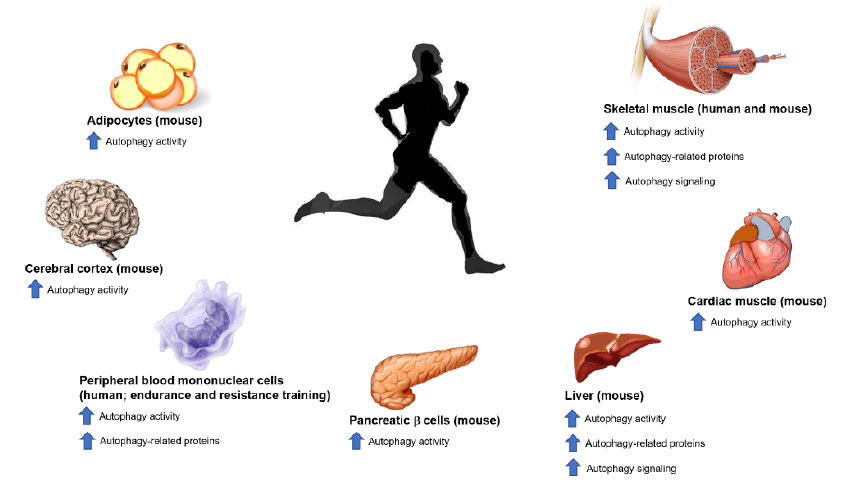
Figure 3. Effect of exercise on autophagy in multiple tissues. Figure 3. E ff ect of exercise on autophagy in multiple